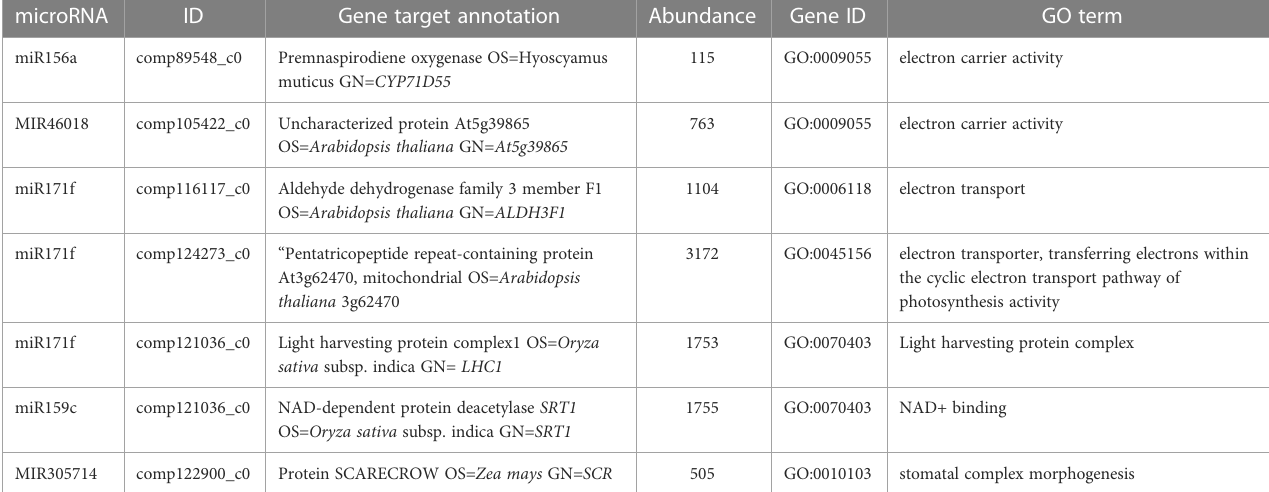
TABLE 2 Target gene ontologies for highly downregulated microRNAs related to photosynthesis. microRNA ID